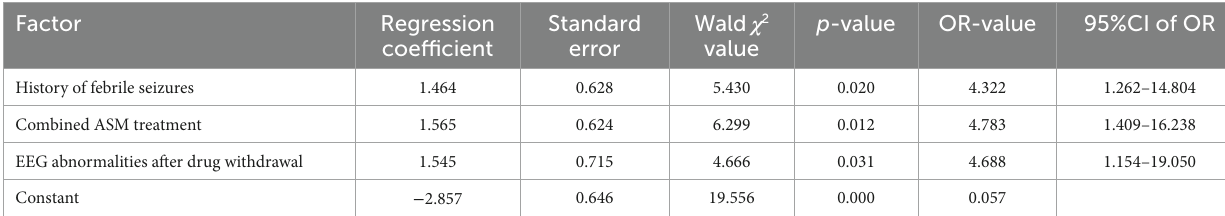
TABLE 4 Results of the multivariate binary logistic regression analysis for recurrence after drug discontinuation in pediatric patients with epilepsy. Factor Regression